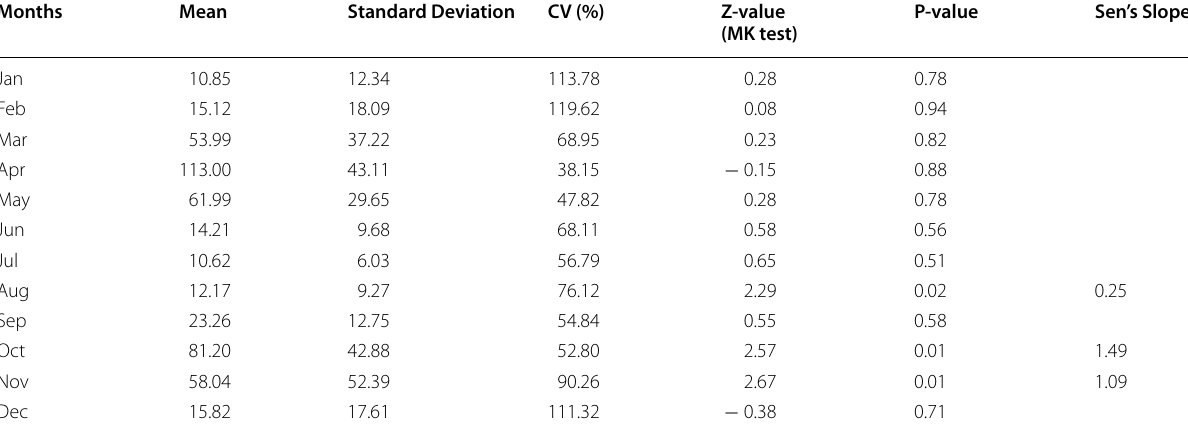
Table 1 Descriptive statistics and test results of monthly precipitation